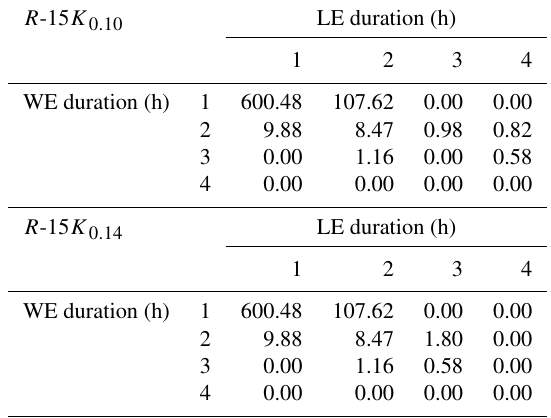
Table 8. Duration matrix results for simulations R -15 0 . 10 and R - 15 0 . 14 .